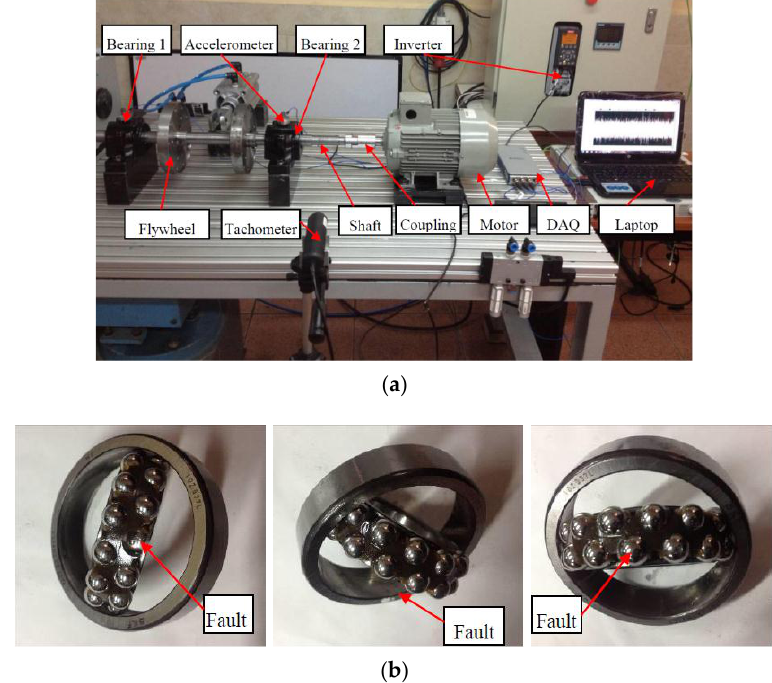
Figure 5. Fault diagnosis configurations for the rolling element bearings: ( a ) experimental set-up; and ( b ) 3 different faulty bearings with an inner race fault ( left ), an outer race fault ( middle ) and a ball fault ( right ), respectively.